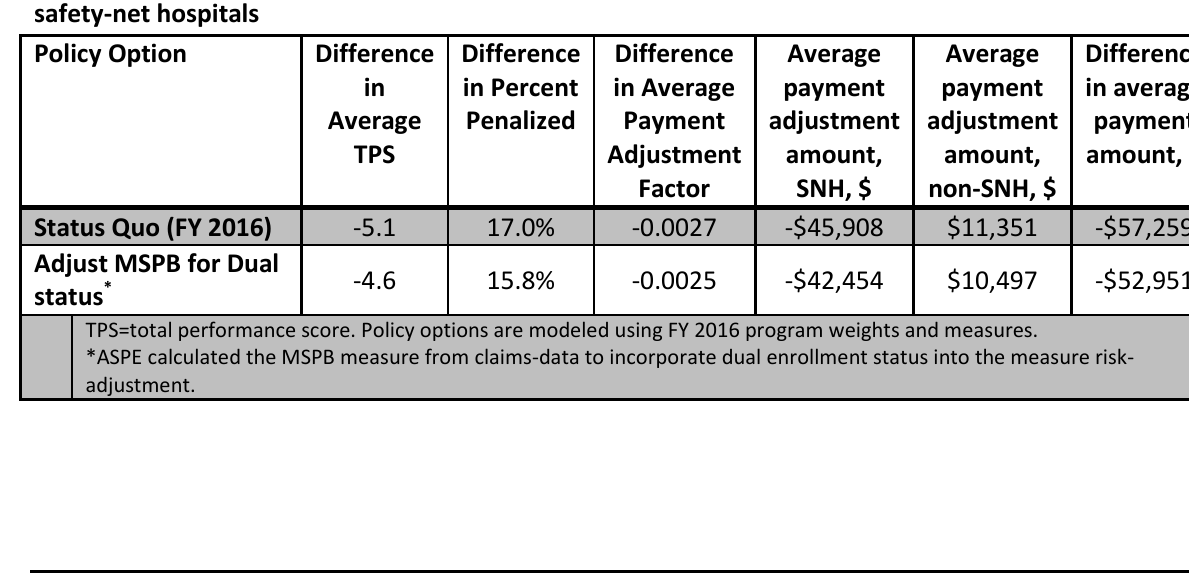
Table 7.14. Summary of Policy Options, differences between safety-net (top 20% DSH) versus